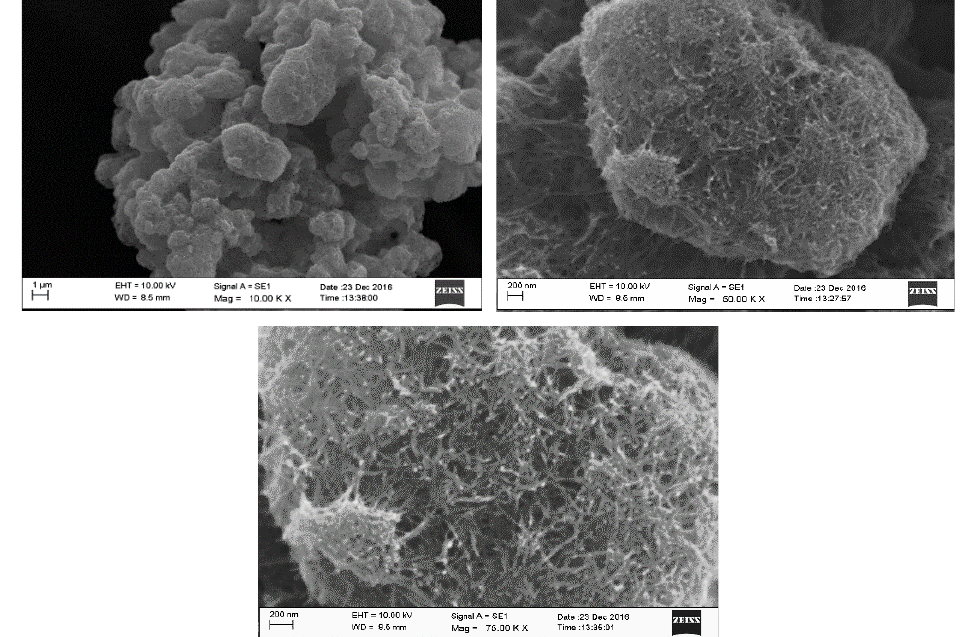
Ti O nanofibers synthesized by hydrothermal synthesis 2 3 7